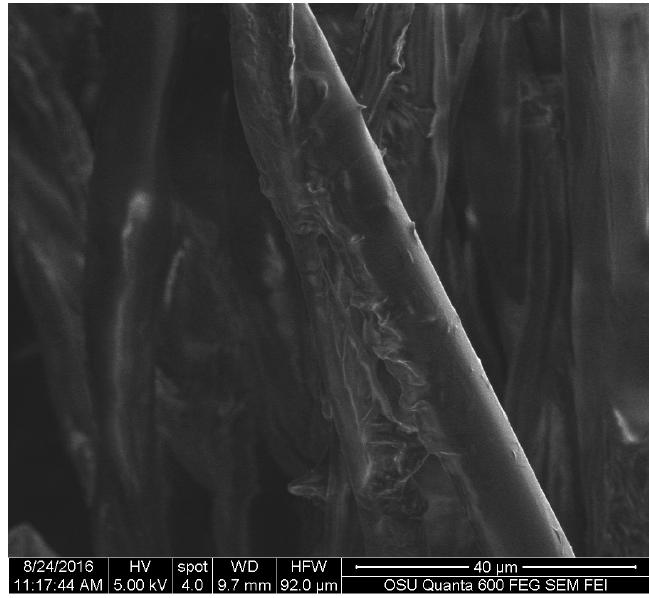
Figure 10. Extracted pigment of S. cuboideum accumulating on top of a cotton fiber. Picture taken with an FEI QUANTA 600 F.